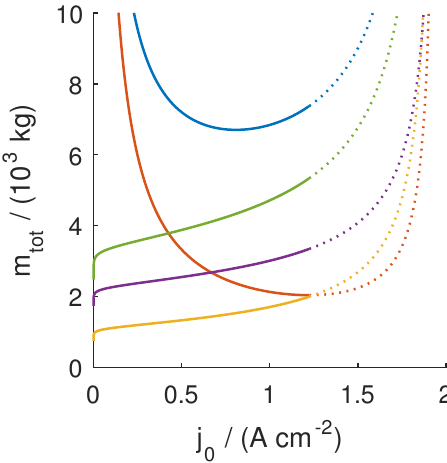
Figure 5. Mass of the fuel cell system and its components as function of working point current density for a reference flight mission with a power demand of P rq = 16.3 MW and an energy demand of E rq = 63.7 MWh, i.e., a medium haul flight [16]. Blue: total mass of the system; Red: mass of the fuel cell; Yellow: mass of the hydrogen fuel; Purple: mass of the empty tank; Green: mass of the tank system (tank+hydrogen). Dotted lines mark the branch above the maximum power